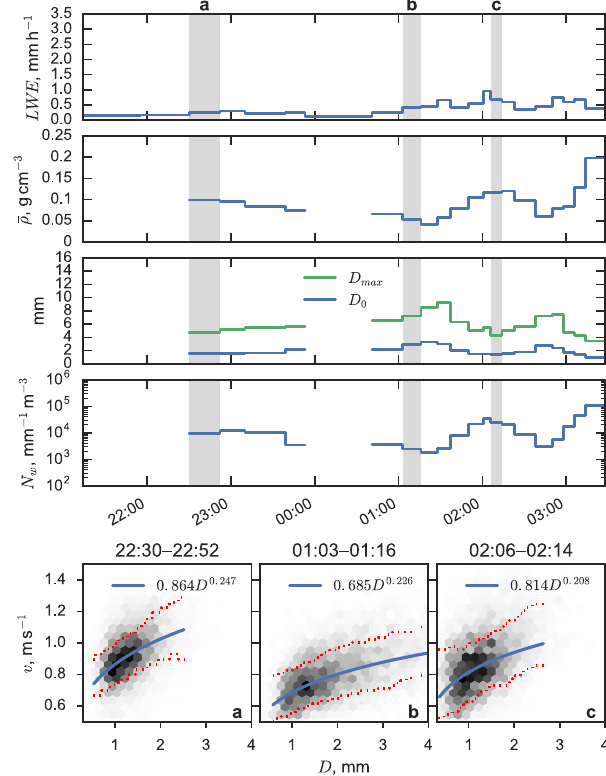
Figure 7. Evolution of snowfall intensity, ensemble mean density and particle size distribution parameters during 18 March 2015 with associated ( v , D ) from three selected time intervals (highlighted in gray). The red dashed lines mark the upper and lower velocity limits where for a given D the KDE value is higher than half maximum.